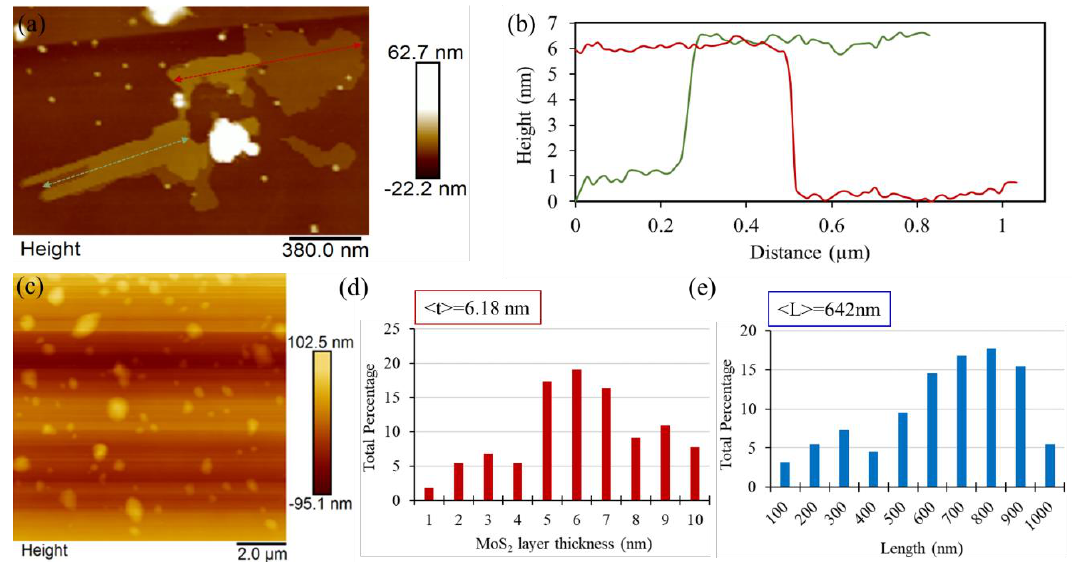
Figure 4. ( a ) An AFM image, ( b ) thickness profile, and ( c–e ) AFM image and its histograms of a 12 h ball milling of F-MoS 2 nanosheets.